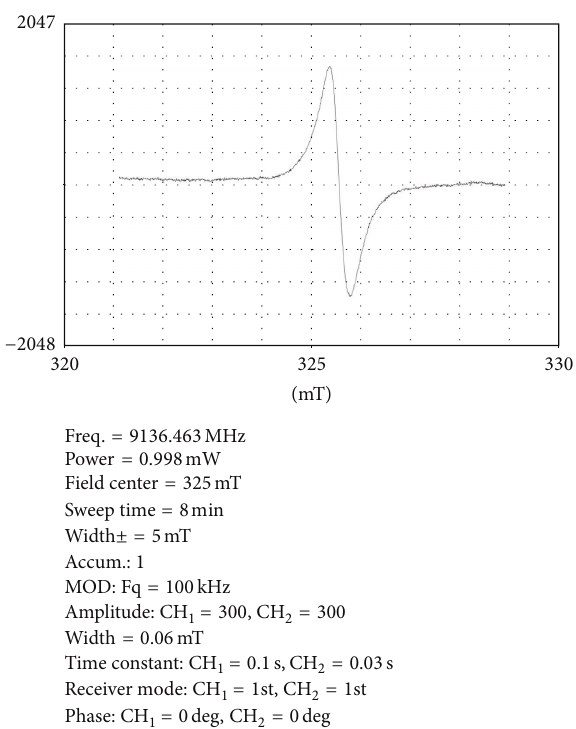
Figure 5: Typical ESR spectrum of humic substances investigated.